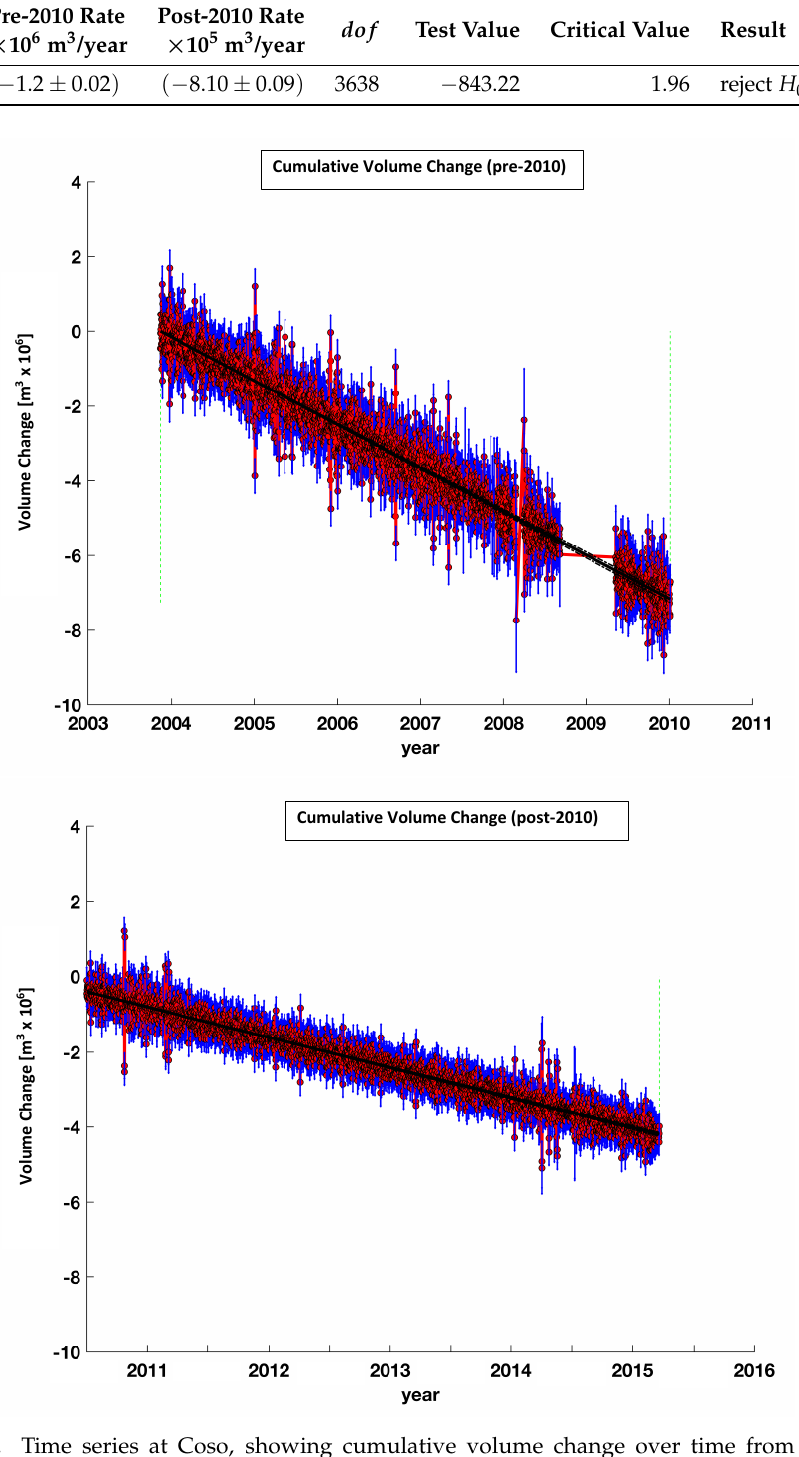
Figure 12. Time series at Coso, showing cumulative volume change over time from temporal adjustment of volume change rates estimated from GPS data spanning 2004 to 2016. Data before 2010 is shown above. Data after 2010 is shown below. Plotting conventions as in Figure